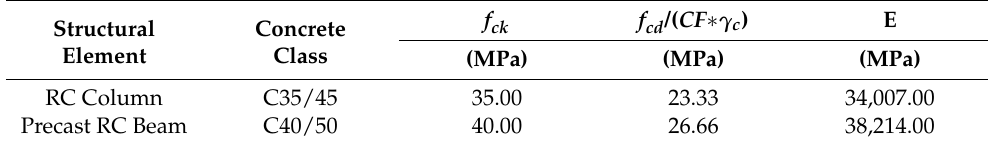
Table 1. Mechanical properties of RC components.